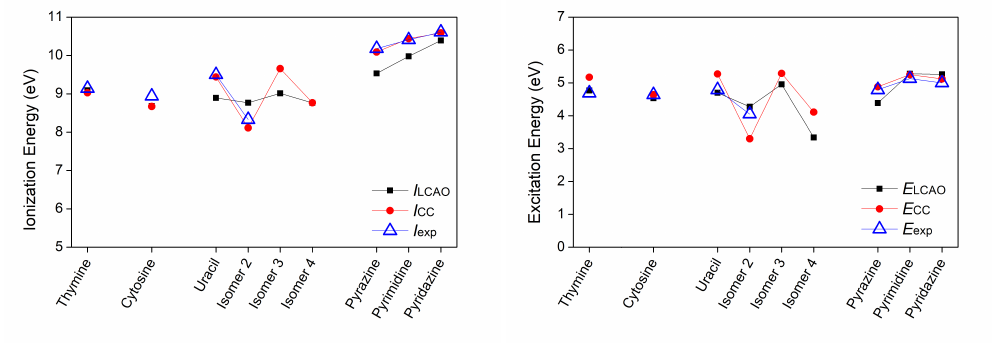
Figure 3. First π ionization energy and first π - π ∗ excitation energy of purines calculated via our LCAO method using all valence orbitals, along with results at the IP-EOMCCSD/aug-cc-pVDZ (vertical ionization energies) and CR-EOMCCSD(T)/aug-cc-pVDZ (vertical excitation energies) level of theory [29], as well as available experimental data. Different isomers are specified in Table 1.